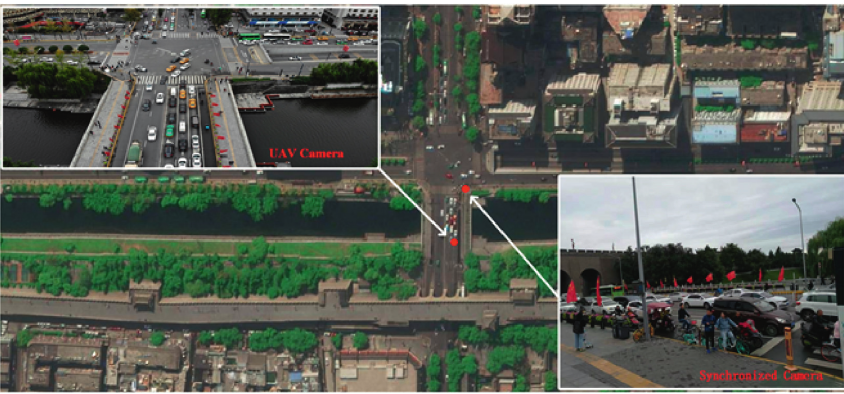
Figure 1: Bird’s eye view and two photos of camera view of W-H